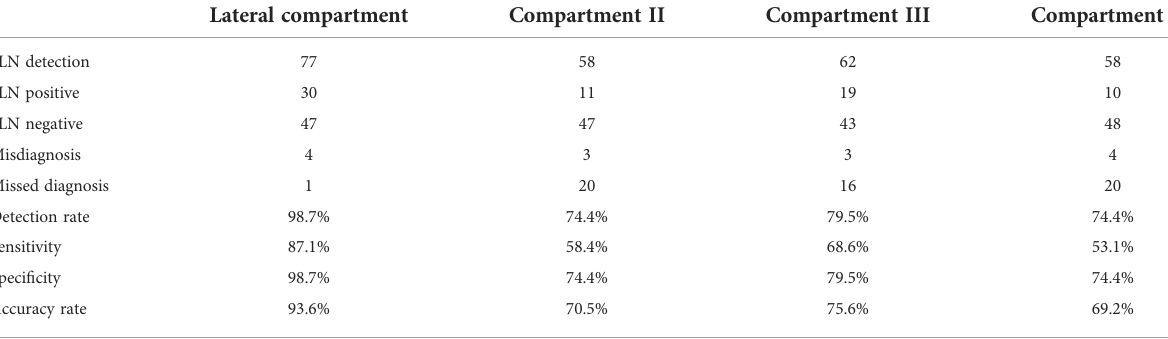
TABLE 2 Results of SLNB in the lateral compartment (n =